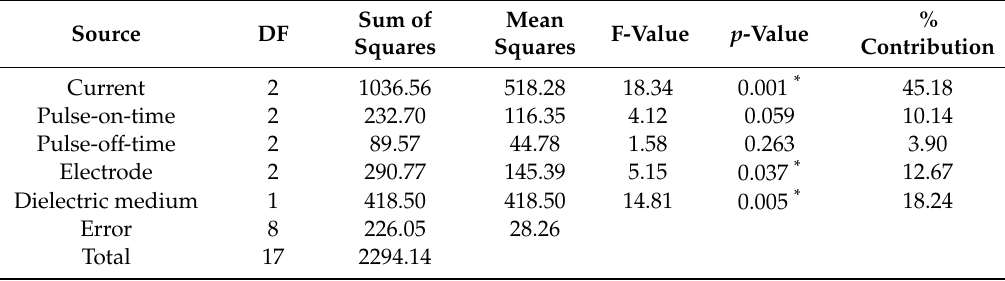
Table 4. ANOVA for Material Removal